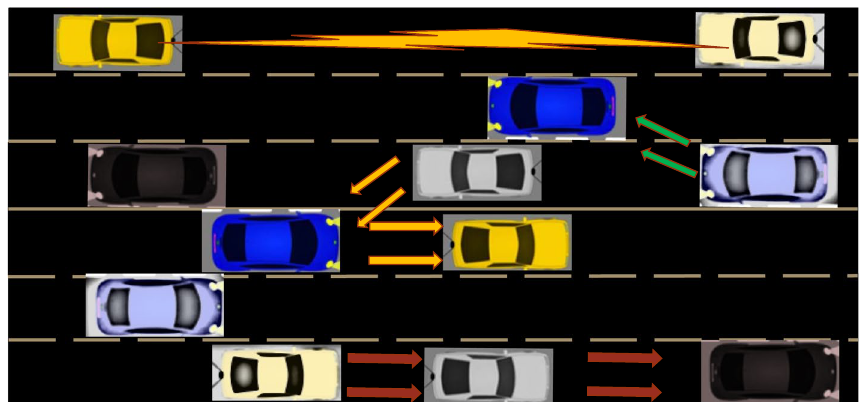
Fig. 1 The proposed framework of 80 cars connects through VLC/RF within 6 lanes road. The car-to-car communication system comprises a framework of 80 cars within six lanes road with three lanes in one direction and the other three lanes in the opposite direction. Green arrows represent single-hop VLC, red arrows represent multi-hop VLC, and yellow arrows represent multi-hop VLC to overcome the field of view problem, while yellow lightening represents single-hop RF. The selected road distance is 25 km. Each car has a variable speed from 60 to 100 km